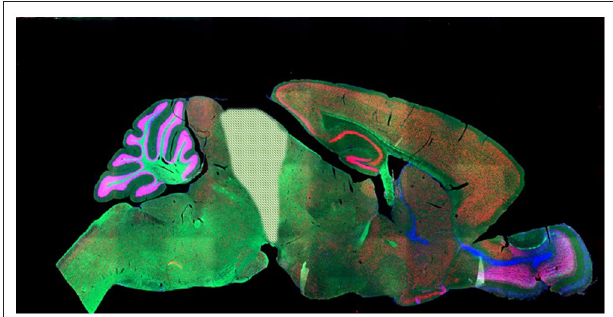
FIGURE 2 | After Woolf (71), showing what is removed in a decerebrate rodent: everything to the right of the pale shaded area (thus cerebral cortices, subcortical gray matter, hippocampus, olfactory bulbs and diencephalon). The pale shaded area (superior colliculi) may be removed too. Note that despite its superficial complexity, the mammalian cerebellum is not involved in P-consciousness [(45), p. 54–55, 83]. Such subjects are generally argued to be pain-free and thus not to need anesthesia for further surgeries [e.g., (5, 72)]. Note that the same is not true for decorticate mammals subject to less severe surgery (e.g., losing only the cortical layers of the cerebra but retaining the thalamus): anesthesia is required for these. (Note that while we find data from these subjects very revealing, we also acknowledge that this work–along with that on spinally transected rats– is highly invasive and disturbing). Photo: Mouse brain, NIH National Institute of Child Health and Human